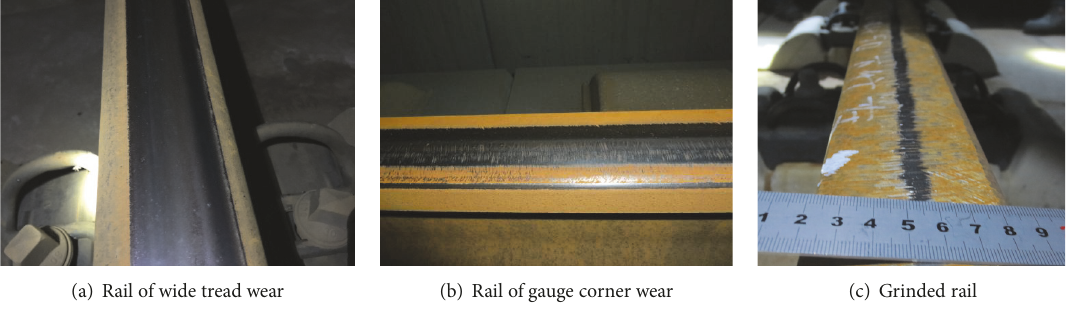
Figure 3: Field investigation.